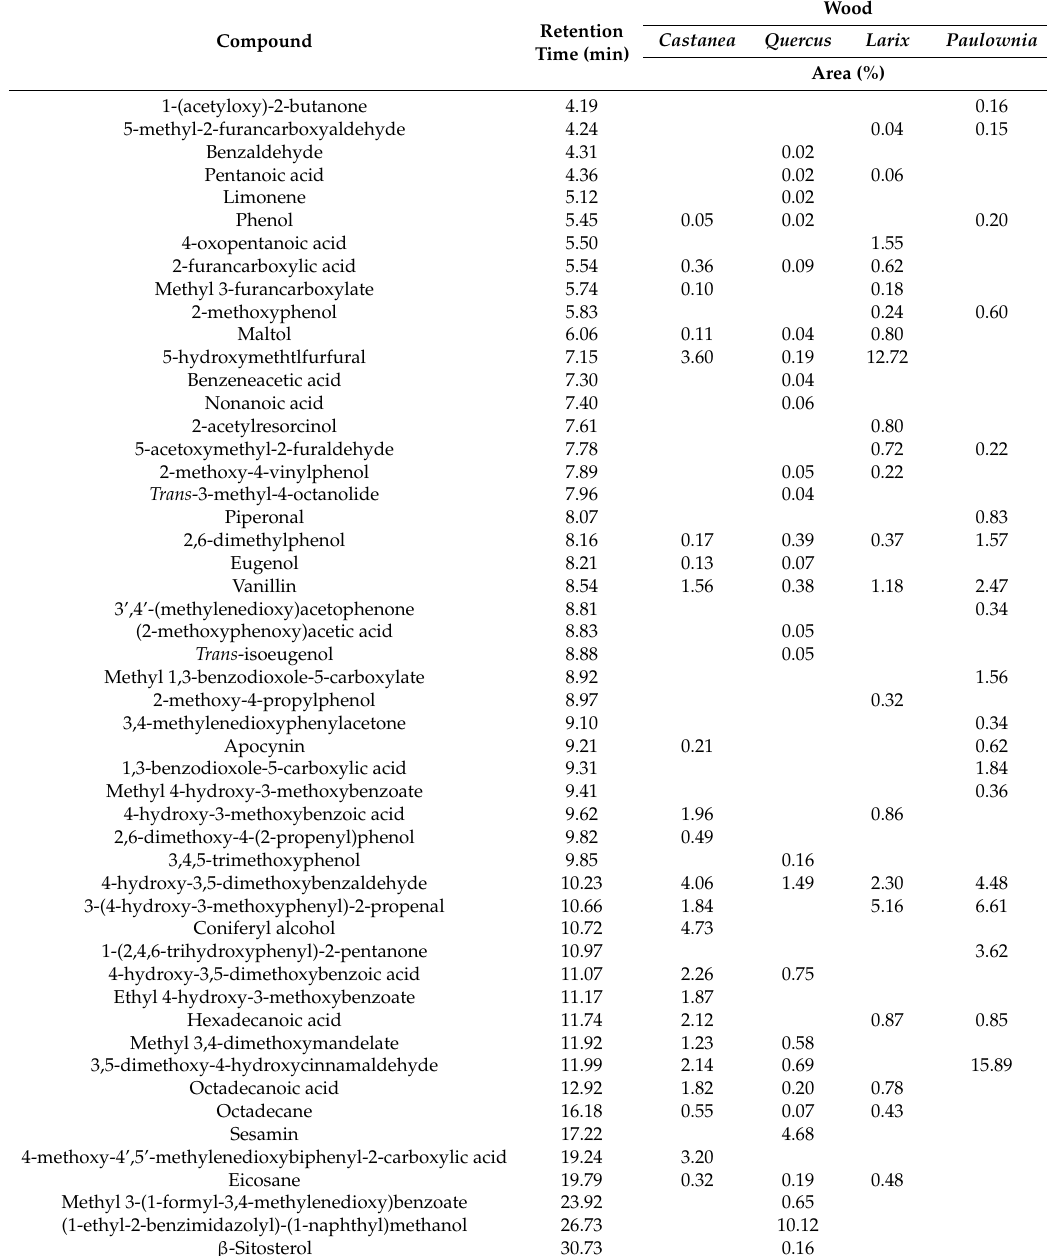
Table 2. Gas chromatography-mass spectrometry (GC-MS) analysis of chloroform soluble water extractives (results presented in area